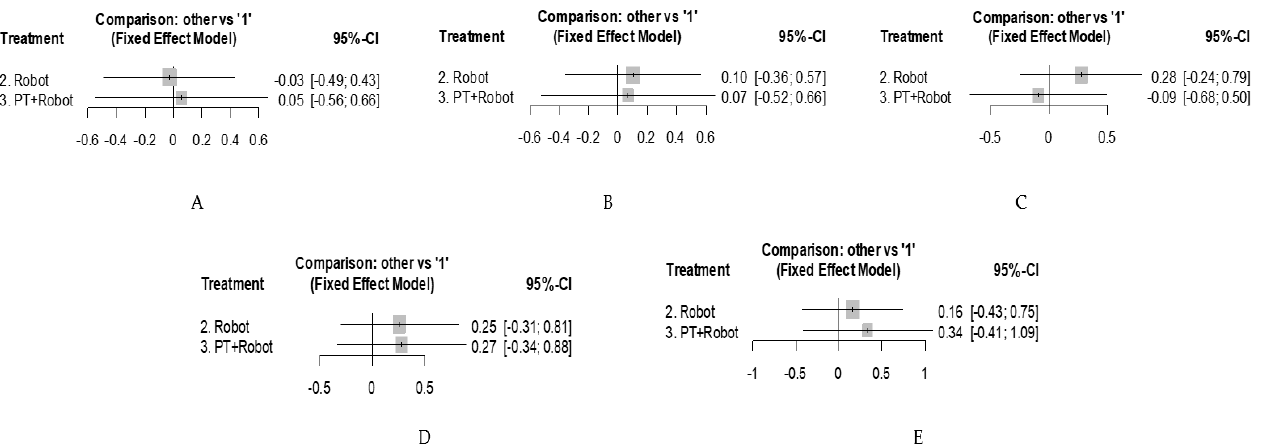
Figure 2. Comparisons of robot-assisted training vs. physiotherapy vs. physiotherapy + robot-assisted training: ( A ) gross motor function measure; ( B ) speed; ( C ) endurance; and ( D ) step length.